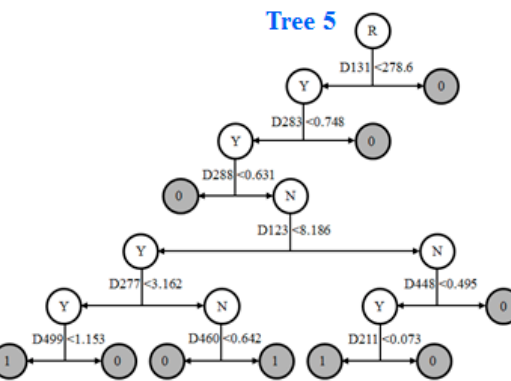
Figure 6. Decision trees of the AFP binding activity prediction DF model. The descriptors and their criteria that were used to split the intermediate nodes are given under the nodes. The left nodes are the sets of chemicals that meet the criteria for splitting their parent nodes; the right nodes represent the sets of chemicals that do not meet the criteria. The root node (whole training data set) and the intermediate nodes are presented in empty/white circles. Letter Y in a circle indicates the chemicals in the node meet the splitting criterion, whereas the letter N means the chemicals do not meet the splitting criterion. The terminal nodes are the leaves of the trees where the AFP binding activity predictions were determined and are shown in grey circles. Number 1 in a circle indicates that the chemicals in the node are predicted as AFP binders while number 0 marks the node where chemicals are predicted as AFP non-binders. Table 3. The experimental and predicted AFP binding activity of the external data set.